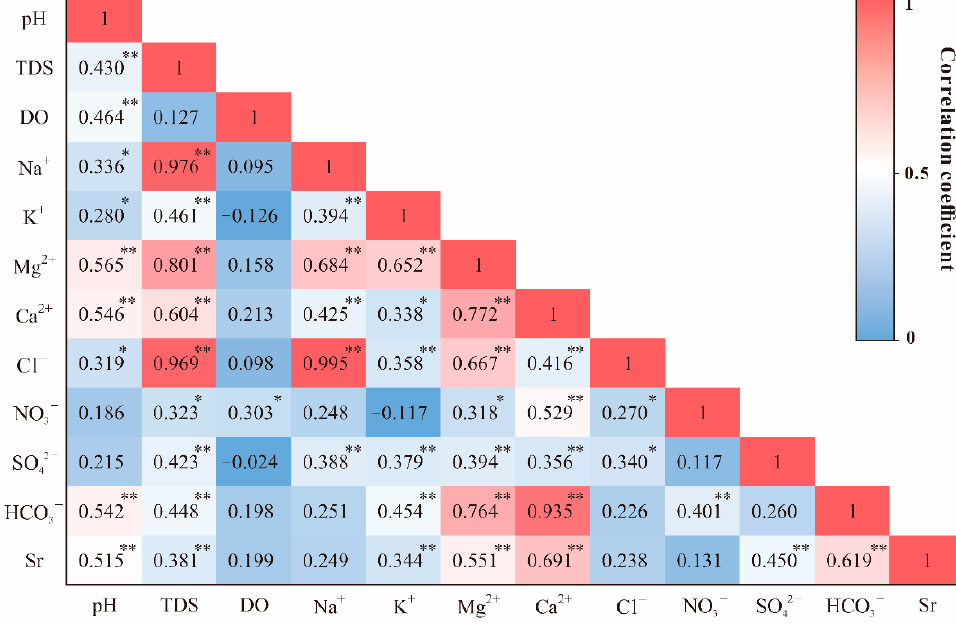
Figure 4. Pearson correlation coefficients of selected parameters measured in the MRB. * Correlation is significant at p < 0.05 level; ** Correlation is significant at p < 0.01 level.